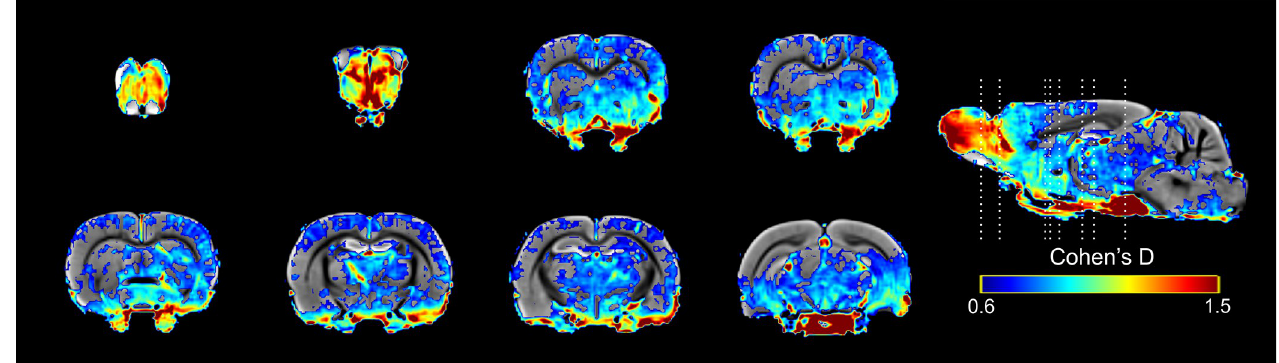
Fig 11. Results of the Cohen’s D analysis from the comparisons of sexual behavior group with 16 mg/kg in session 10 against its session 1.